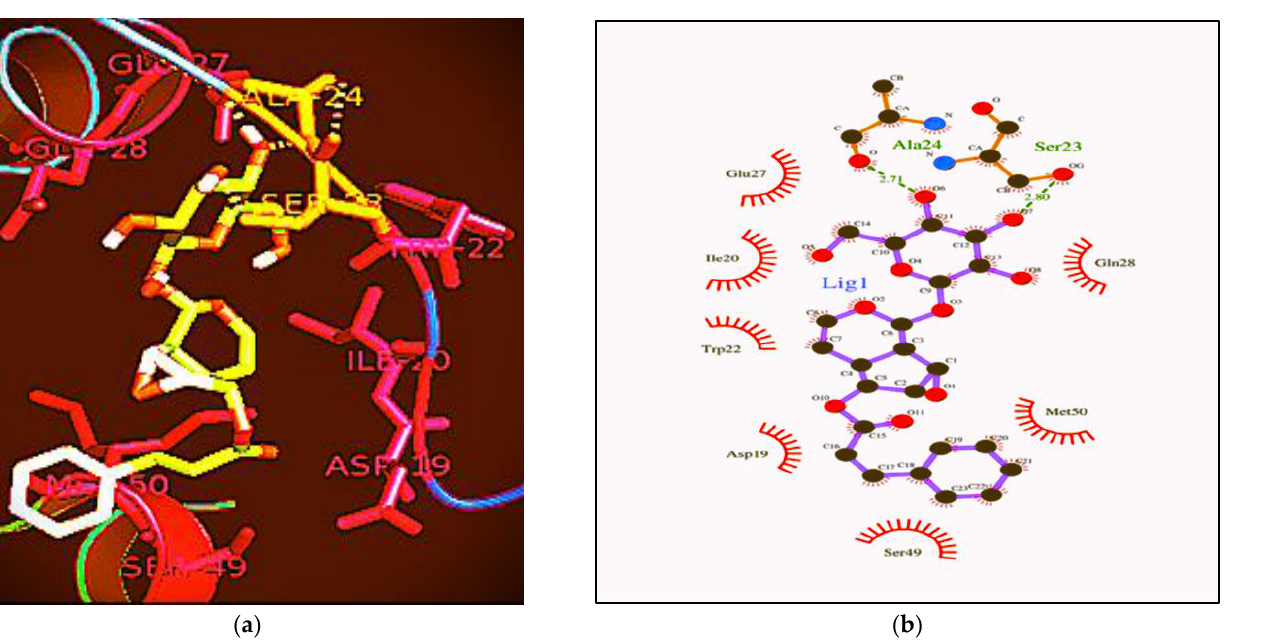
Figure 6. The antimicrobial potential of Picroside – 1 on the DfrA1 DHFR protein sequence of Yersinia enterocolitica . ( a ) Docking of Picrosode – 1. ( b ) Lig – plot of Picroside – 1.